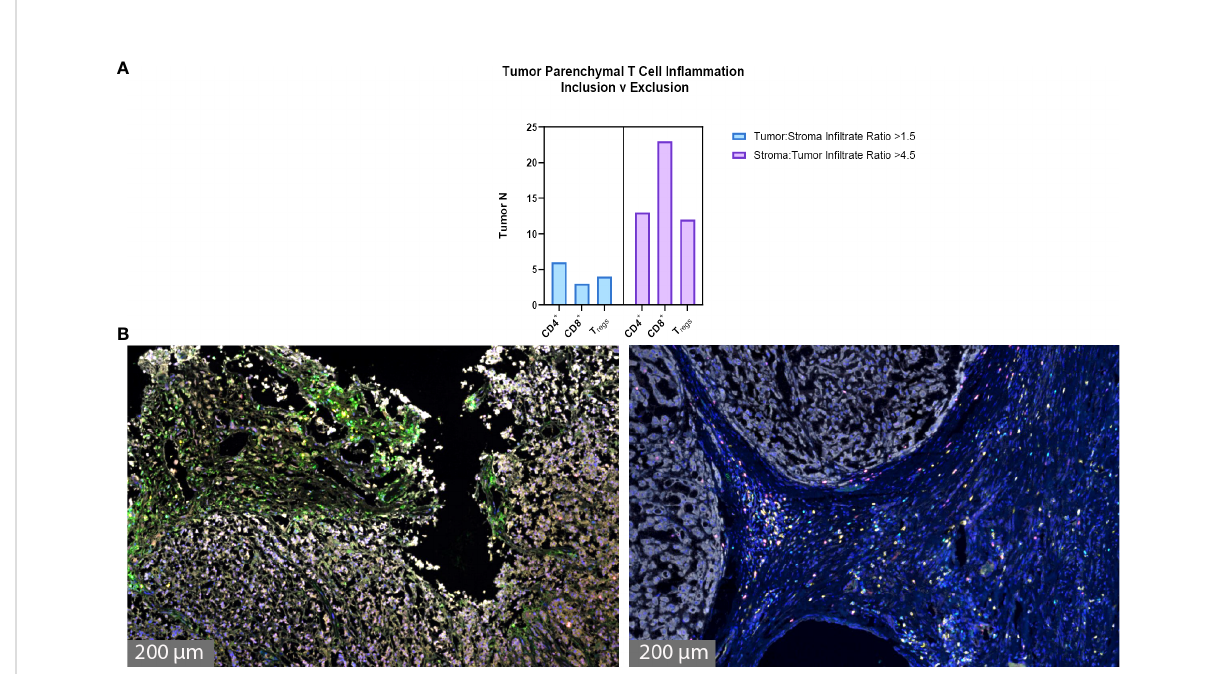
FIGURE 3 Chordoma tumor parenchymal T cell inclusion versus exclusion. T cell compartment in fl ammation in chordoma more commonly takes on a tumor parenchymal exclusion, rather than inclusion, pattern (n = 57 individual tumors). (A) A tumor:stroma T cell in fi ltrate ratio >1.5 de fi ned substantial tumor parenchymal inclusion. A stroma:tumor T cell in fi ltrate ratio >4.5 de fi ned substantial tumor parenchymal exclusion. (B) Representative chordoma samples with heavy tumoral in fi ltrate (left) versus heavy stromal in fi ltrate